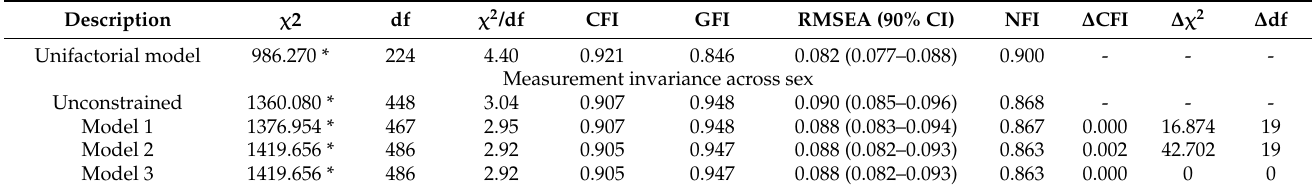
Table 3. Model fit indices in the unifactorial model and configurational invariance by sex.